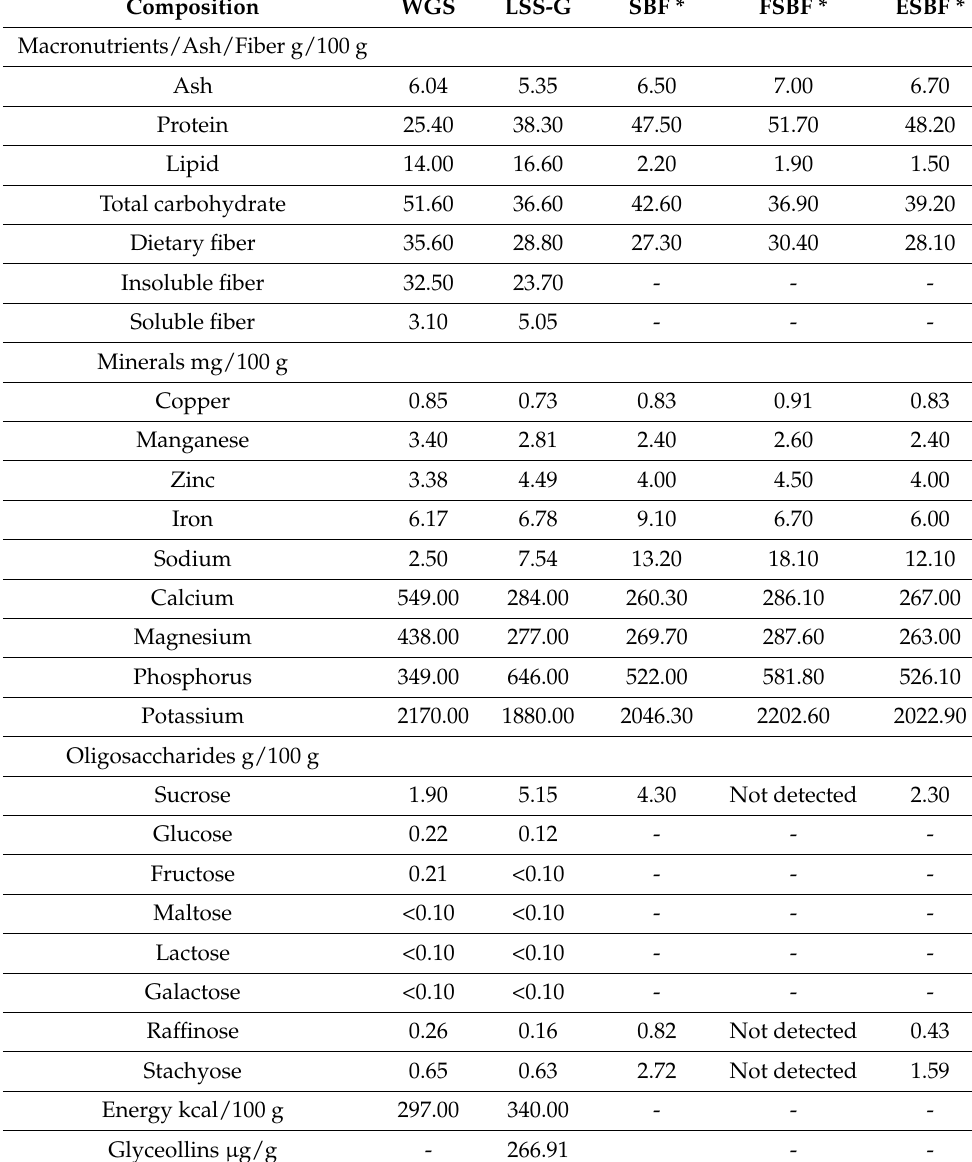
Table 5. Composition of the whole green soybean (WGS) and live soybean seeds (LSS-G) processed in the study and commercial soybean flour (SBF) and its fermented (FSBF) and enzymatically hydrolyzed (ESBF)